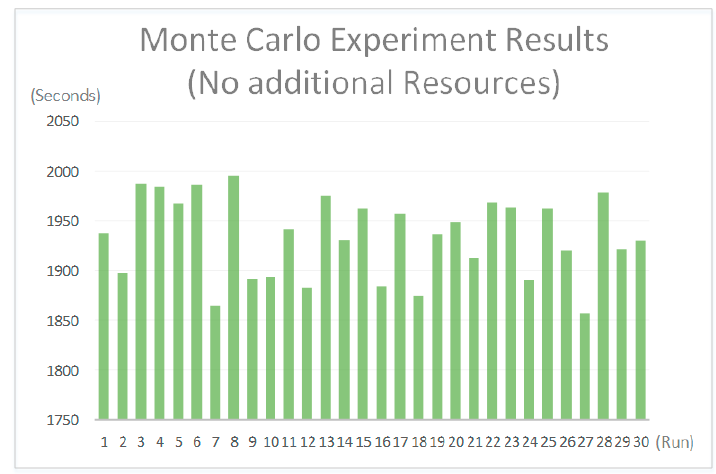
Figure 5. Two stochastic behaviors of nurses will result in two different outcomes.